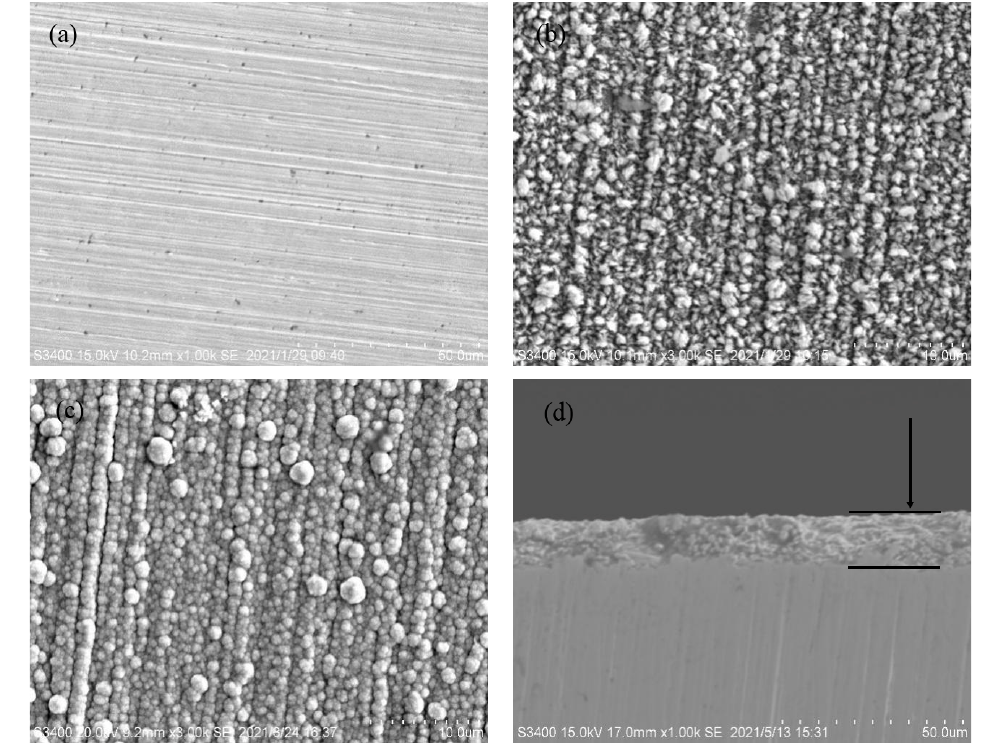
Figure 9. The SEM photograph of Q235, Co and Co-Mo alloy coatings: (( a ) Q235; ( b ) Co coating; ( c ) Co-Mo alloy coating; ( d ) the thickness of Co-Mo alloy